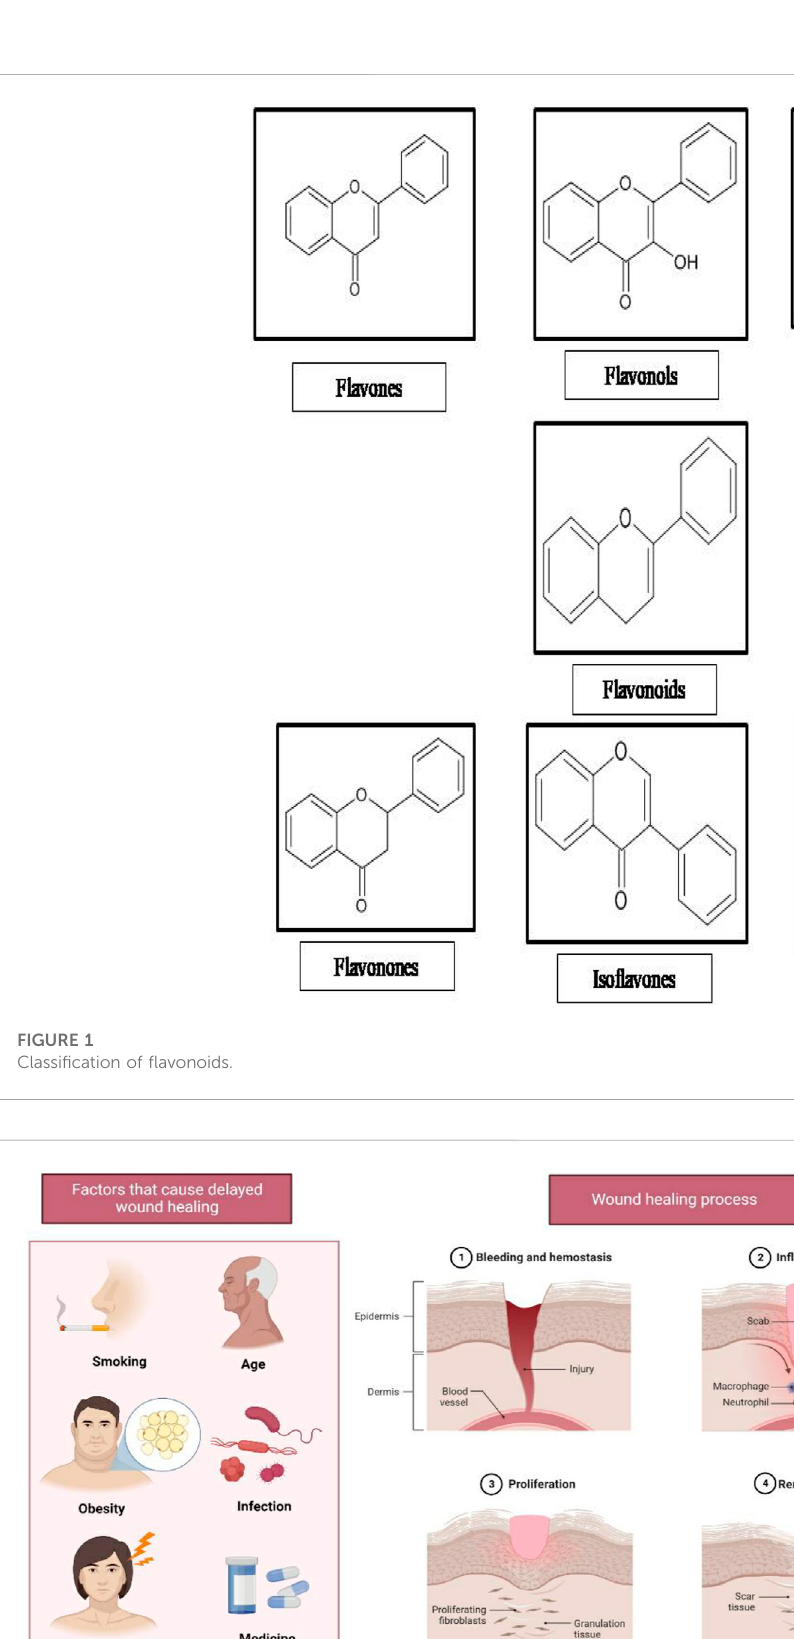
FIGURE 2 Woundhealingpropertiesof D.viscosa leaves.Stressandobesityaretwoofthemanyfactorsthatmightcontributetodelayedwoundhealing.Theplant ’ s phytoconstituents, which have a variety of properties including anti-in fl ammatory, antibacterial, antidiabetic, and antiulcer properties, may be useful for the treatment of infected